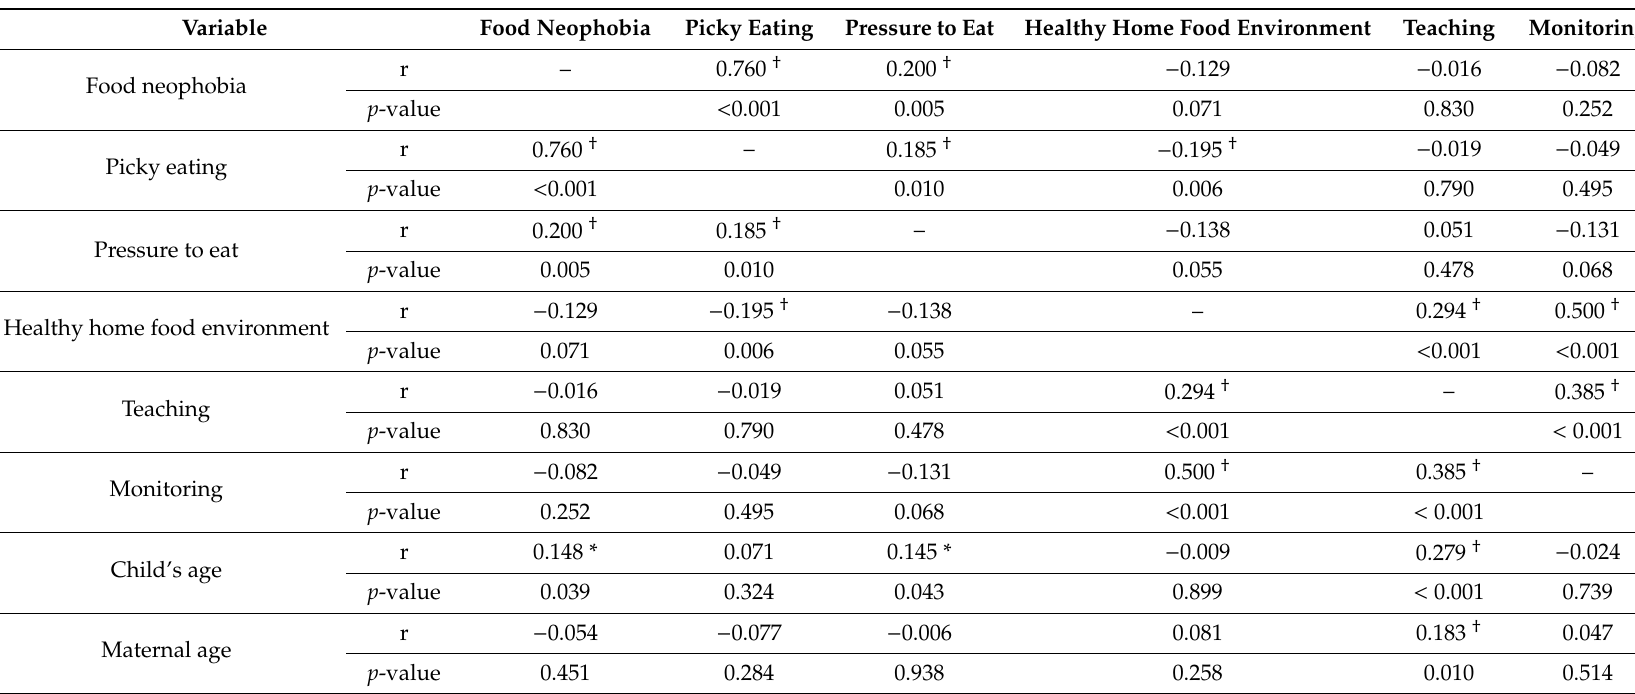
Table 2. Intercorrelations among measures of food neophobia, picky eating, and maternal feeding practices using Spearman correlation matrix ( n = 195). Variable Food Neophobia Picky Eating Pressure to Eat Healthy Home Food